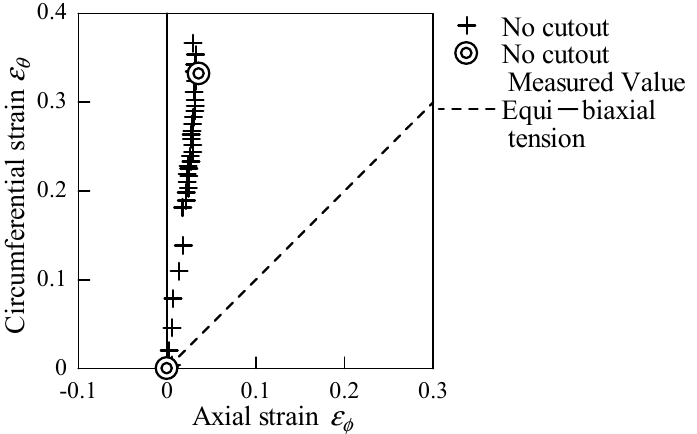
Figure 11. Strain path measured by image processing and forming limit strain measured by micro- scope.